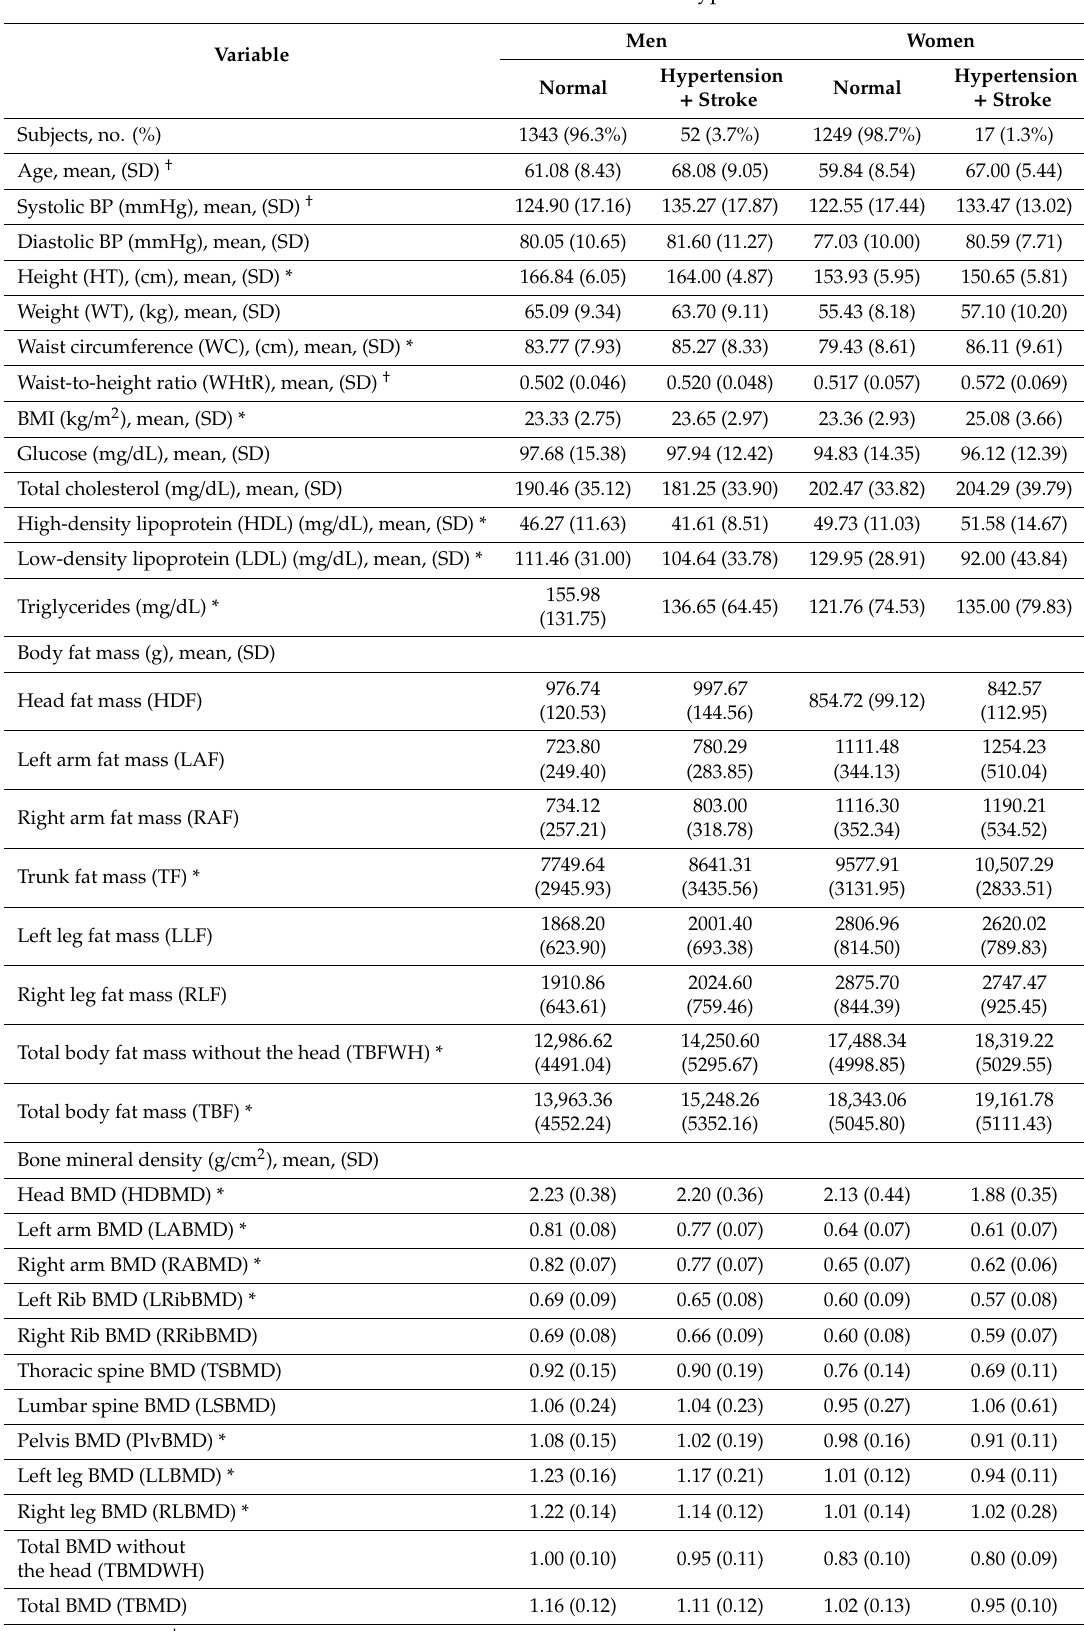
Table 2. Basic characteristics of all variables for both hypertension and